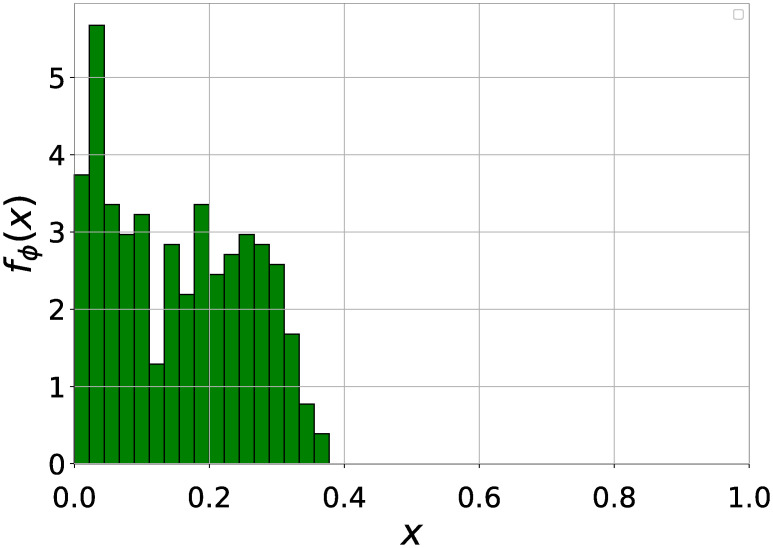
Probability density function fϕ(x) of the vulnerability ϕ of an airport.The average vulnerability is E[ϕ] = 0.15 and the variance is Var[ϕ] = 0.01. In total 45 bins are split within the interval [0, 1] with the same bin size. The probability density fϕ(x) at a given bin x eqals the percentage of the airports whose vulnerability falls within the bin normalized by the bin size 1/45.